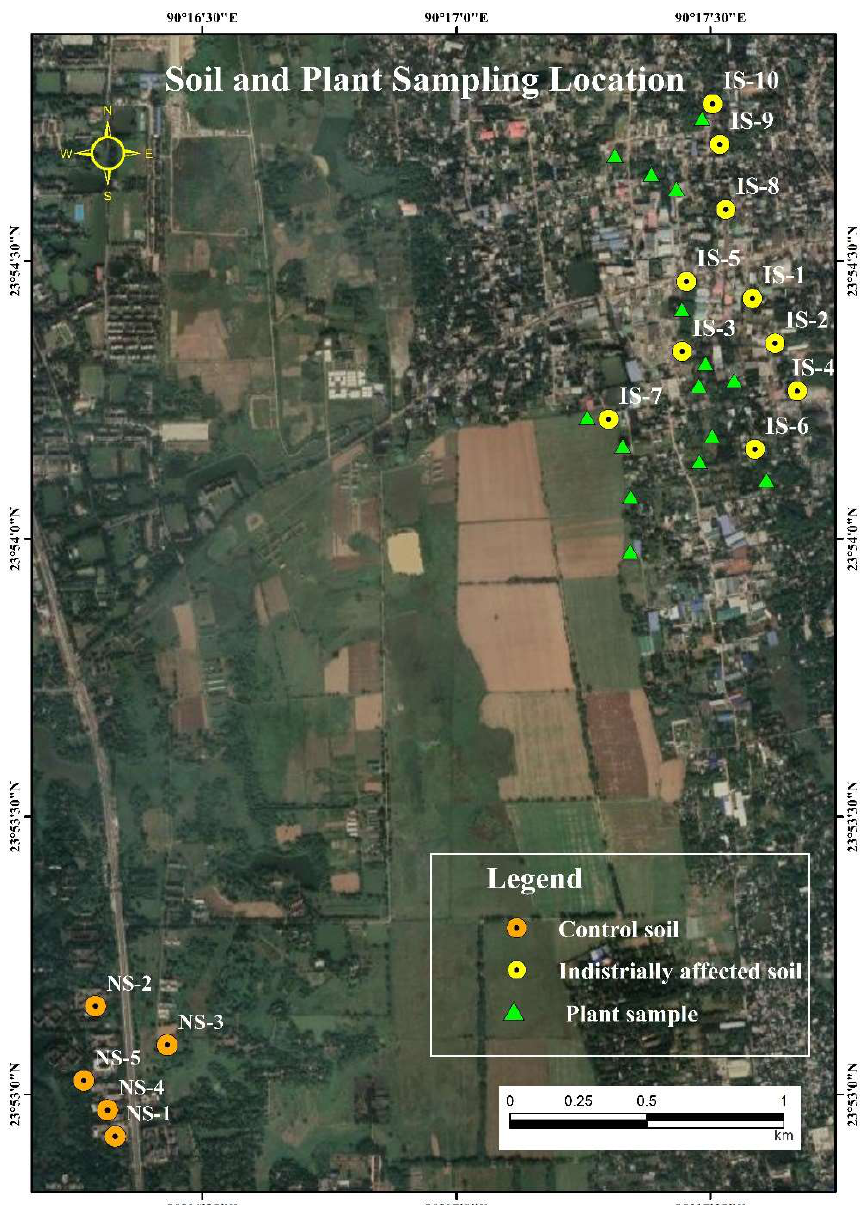
Figure 1. Map of soil (control and affected) and vegetable sampling locations.